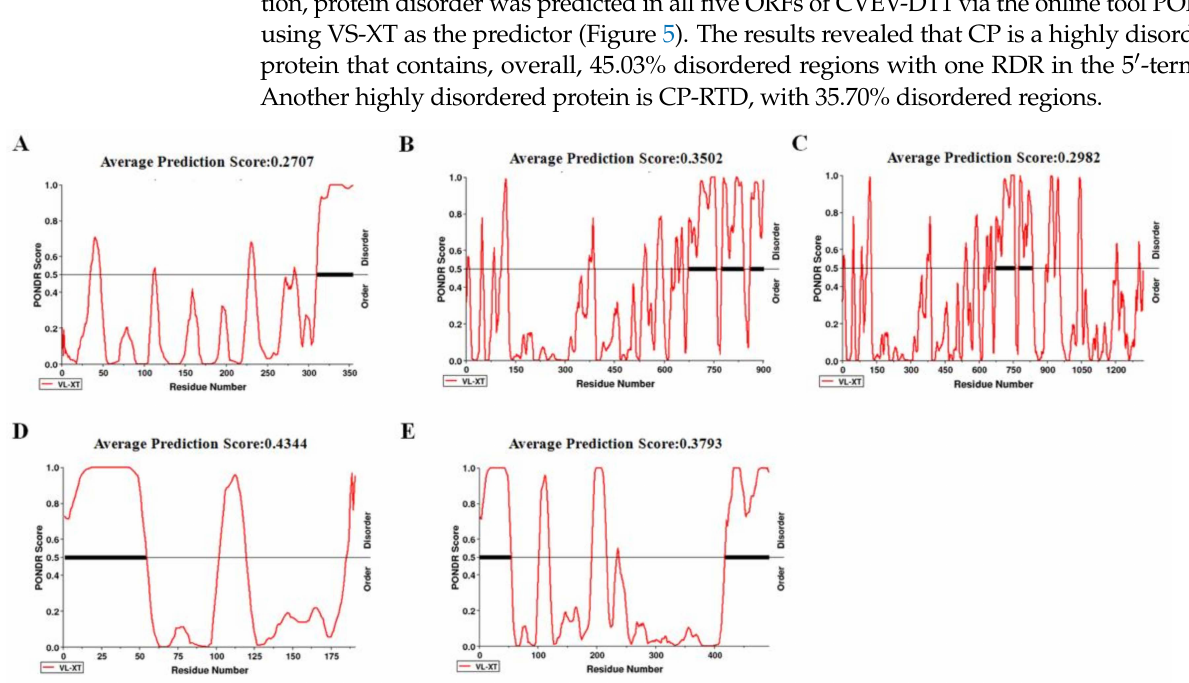
Figure 5. Disorder analysis of CVEV-encoded proteins using IDR online forecasting site with the algorithm VL-XT. The protein disorder of ORF0 ( A ), ORF1 ( B ), ORF2 ( C ), ORF3 ( D ) or ORF5 ( E ) was predicted,